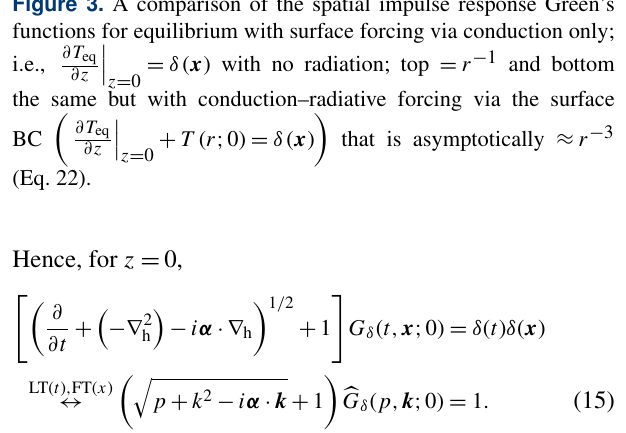
(cid:19) that is asymptotically ≈ r − 3